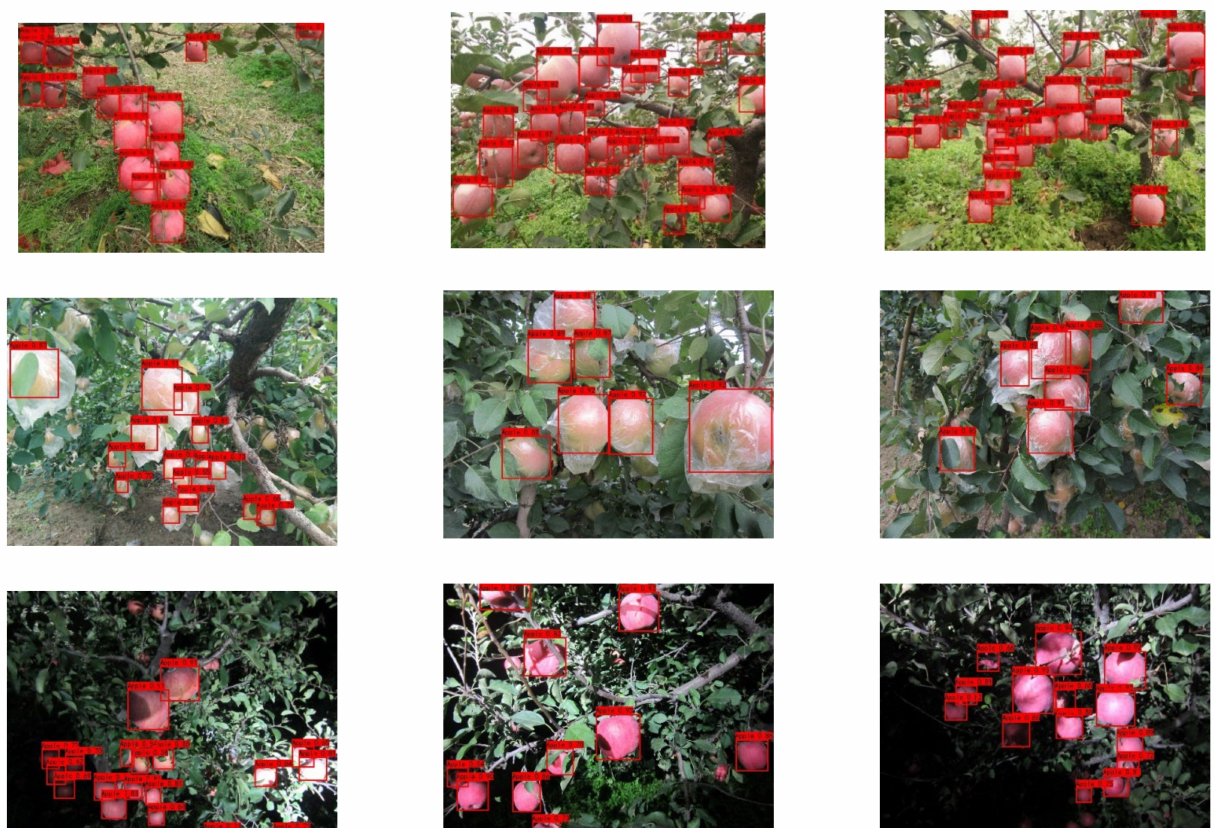
Figure 8. Apple detection effect in natural environment based on ShufflenetV2-YOLOX network